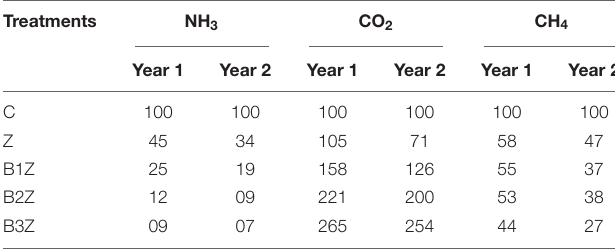
TABLE 3 | Relative gaseous losses compared to control from arable land after co-application of zeolite and biochar along with chemical fertilizers. Treatments